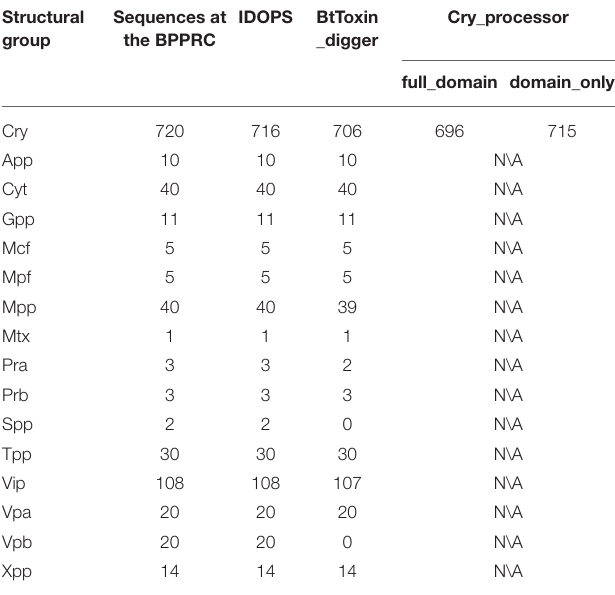
TABLE 3 | Benchmark of tools identifying pesticidal sequences from the Bacterial Pesticidal Protein Resource Center (BPPRC). Structural